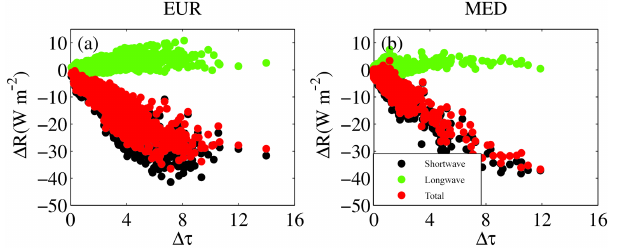
Figure 3. Mean downward surface shortwave ( (cid:49)R SW , black), long- wave ( (cid:49)R LW , green), and total ( (cid:49)R tot , red) radiation differences as a function of the mean COD difference ( (cid:49)τ ) over the EUR (a) and MED (b)